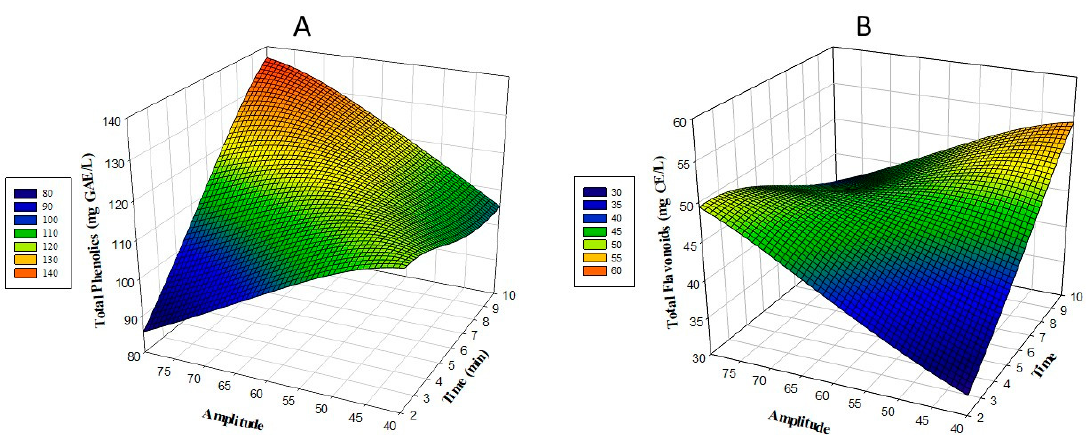
Figure 1. Three-dimensional (3D) response surface plots of the total phenolic content (TPC) ( A ) and total flavonoid content (TFC) ( B ) analysis, as a function of significant interaction